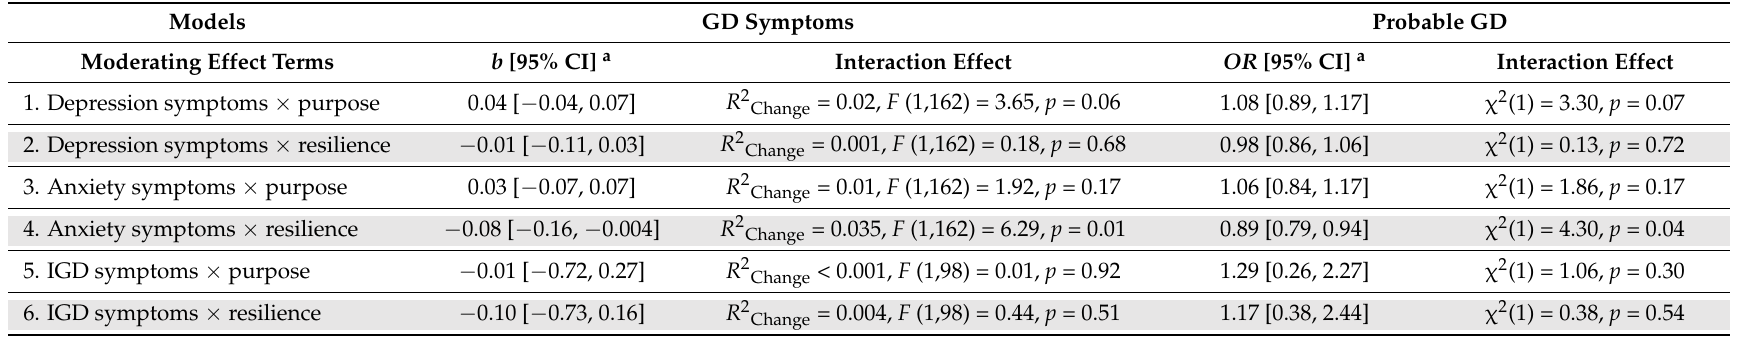
Table 2. Exploring Potential Moderating Effects on GD Symptoms and Probable GD